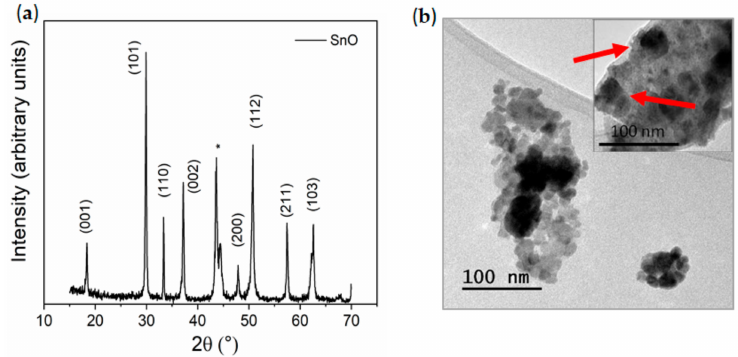
Figure 1. ( a ) XRD pattern and ( b ) TEM micrographs from SnO nanoparticles. The inset in ( b ) shows some nanoplates, marked with arrows. The peak marked with an asterisk in ( a ) corresponds to the sample holder.